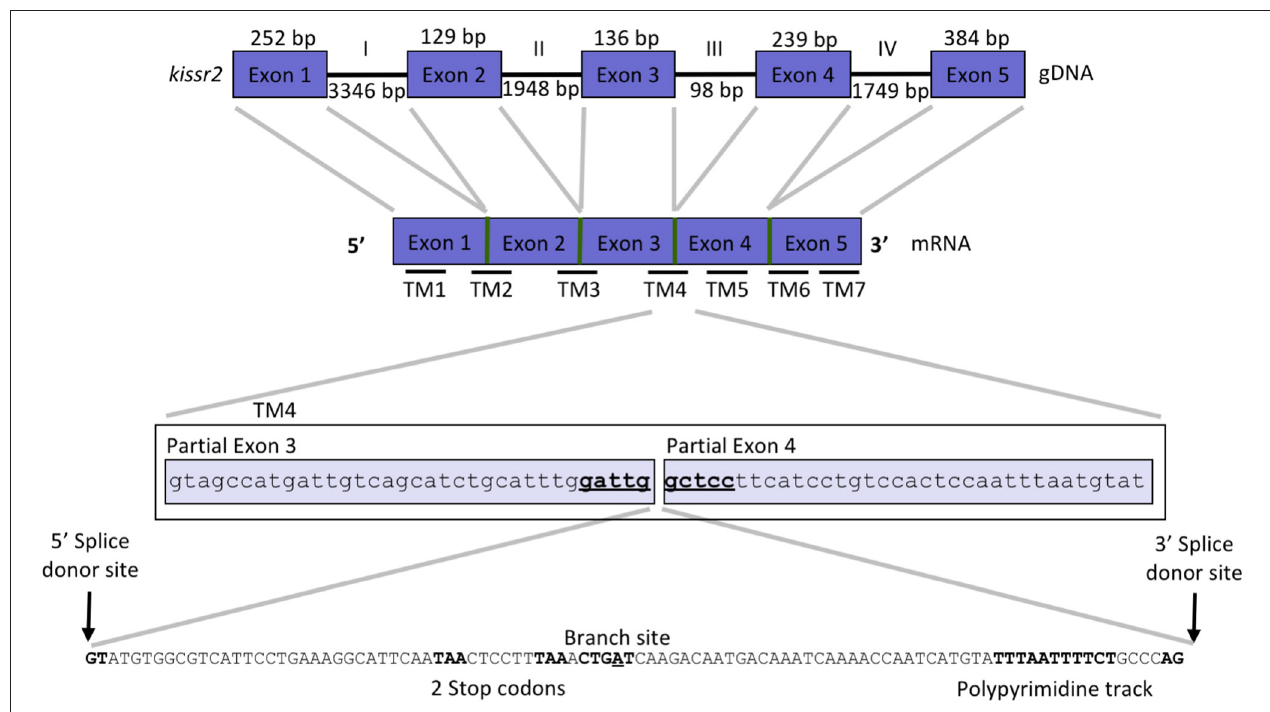
FIGURE 1 | Gene structure of kissr2 in pejerrey. Exons are displayed as blue boxes and introns as thick lines. Thinner horizontal lines at the bottom of the cDNA scheme, represent the site of the transmembrane domains (TMs). A detail of pejerrey intron 3 of kissr2 sequence with features consistent with the presence of a mechanism for alternative splicing is